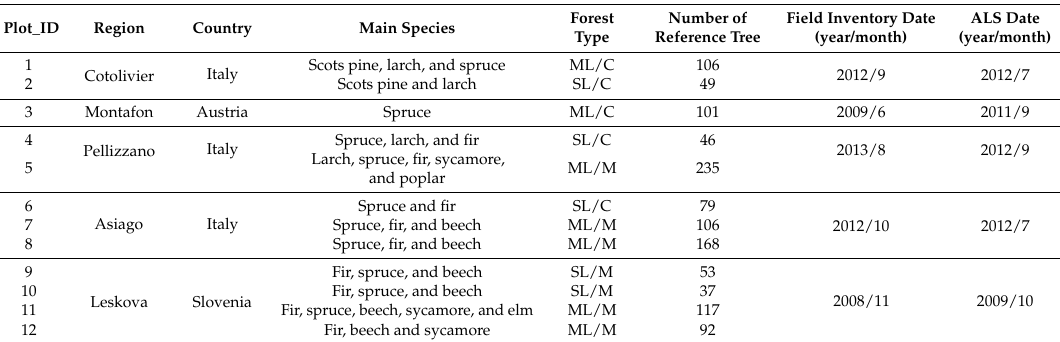
Table 1. Region and forest type of experimental plots.